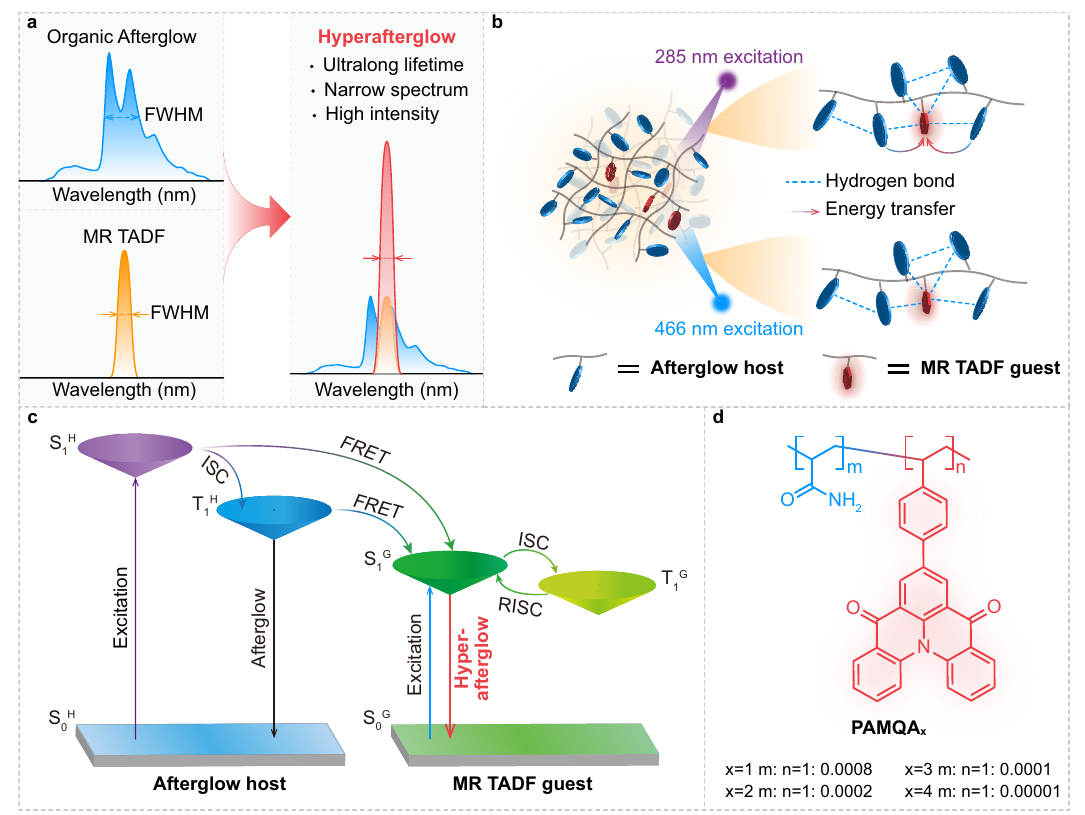
Fig. 1 | Schematic illustration of the hyperafterglow and rational design strategyofhyperafterglowpolymers.a Spectravariationofconventionalorganic afterglow and hyperafterglow emission. b Molecular design of amorphous hyper- afterglowpolymersthroughtheintegrationof MRTADFguest(emitters)into rigid afterglow polymeric host (sensitizers). c Proposed luminescent mechanism for